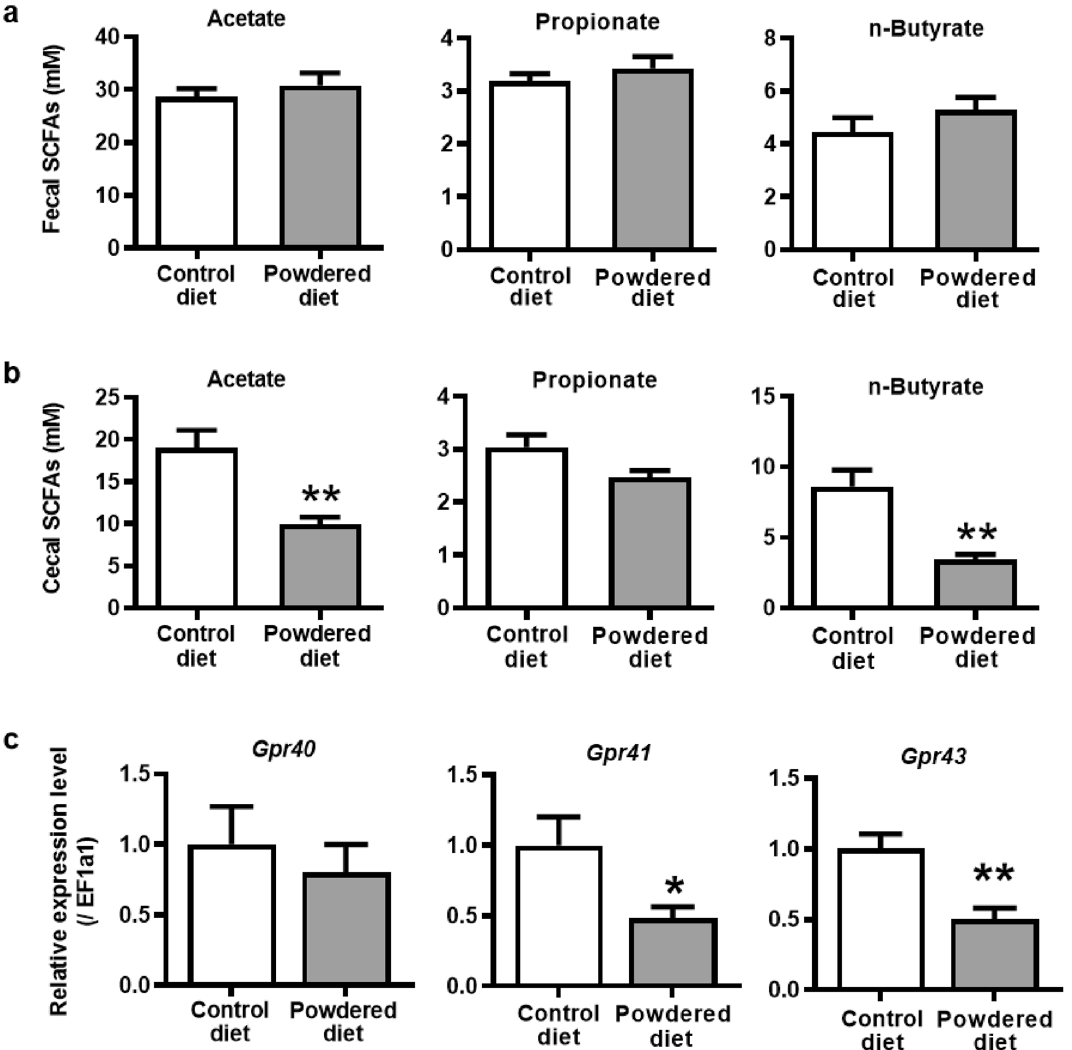
Figure 2. Effects of long-term powdered diet feeding on the short-chain fatty acid (SCFA) levels in ( a ) feces and ( b ) cecal contents, and ( c ) colonic expressions of Gpr40 , Gpr41, and Gpr43 in mice starved for 5 h. The amounts of acetate, propionate, and n-butyrate among the SCFAs extracted from the samples collected from the feces (p = 0.4519, 0.3856, and 0.2578, respectively, n = 8 per group) and the cecum (p = 0.0013, 0.0506, and 0.0012, respectively, n = 8 per group). Student’s t -test was used to determine statistical significance. PCR analysis of Gpr40 , Gpr41 , and Gpr43 in the colons of mice (p = 0.5562, 0.0258, and 0.0011, respectively, n = 12 per group). Student’s t -test was used to determine statistical significance. The data are given as the mean ± SEM for each group. *p < 0.05, **p < 0.01; vs. control diet-fed